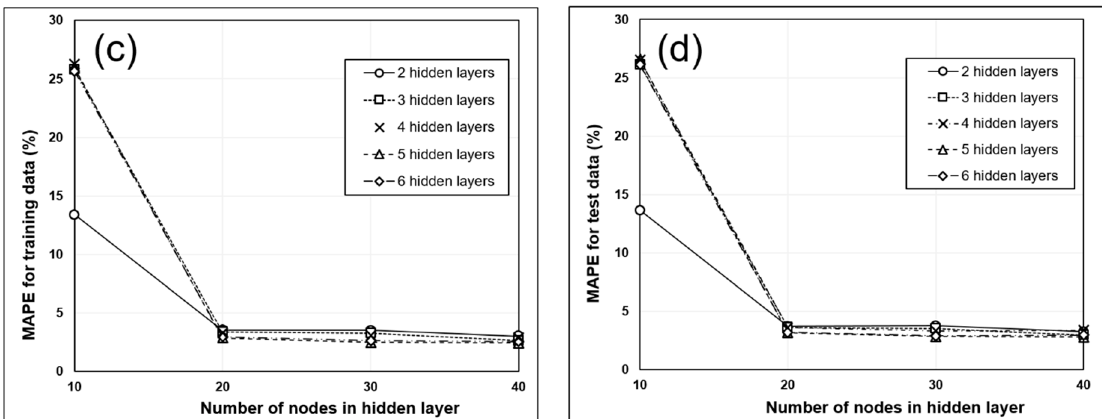
Figure 6. Results of accuracy analysis of DNN models for predicting ore production with different numbers of hidden layers and hidden layer nodes: coefficient of determination for ( a ) training data and ( b ) test data, and MAPE for ( c ) training data and ( d ) test data.